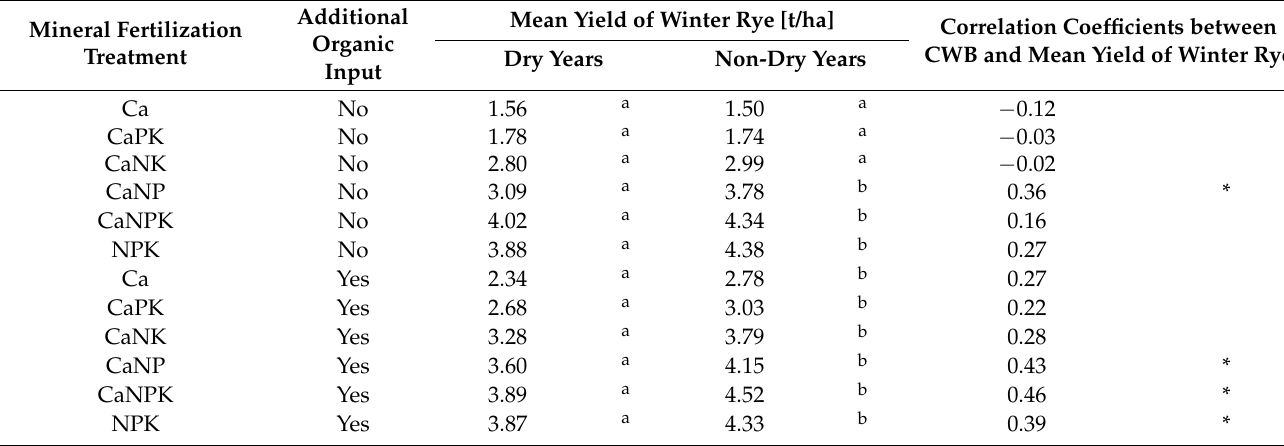
Note: Dry years: CWB from May to June ≤− 100 mm (n = 27); Average or wet years: CWB from May to June > − 100 mm (n = 22) (see also Figure A1); Different small letters indicate significant ( p < 0.05) differences between the mean yield of winter rye in dry versus average/wet years within each treatment; asterisked values indicate significant correlation coefficients ( p <